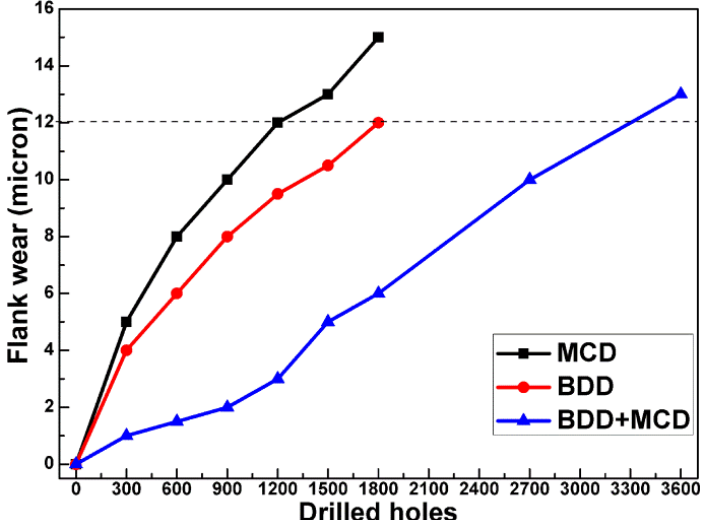
Figure 5. Flank wear for MCD coated, BDD coated and BDD + MCD coated micro drills as a function of drilled